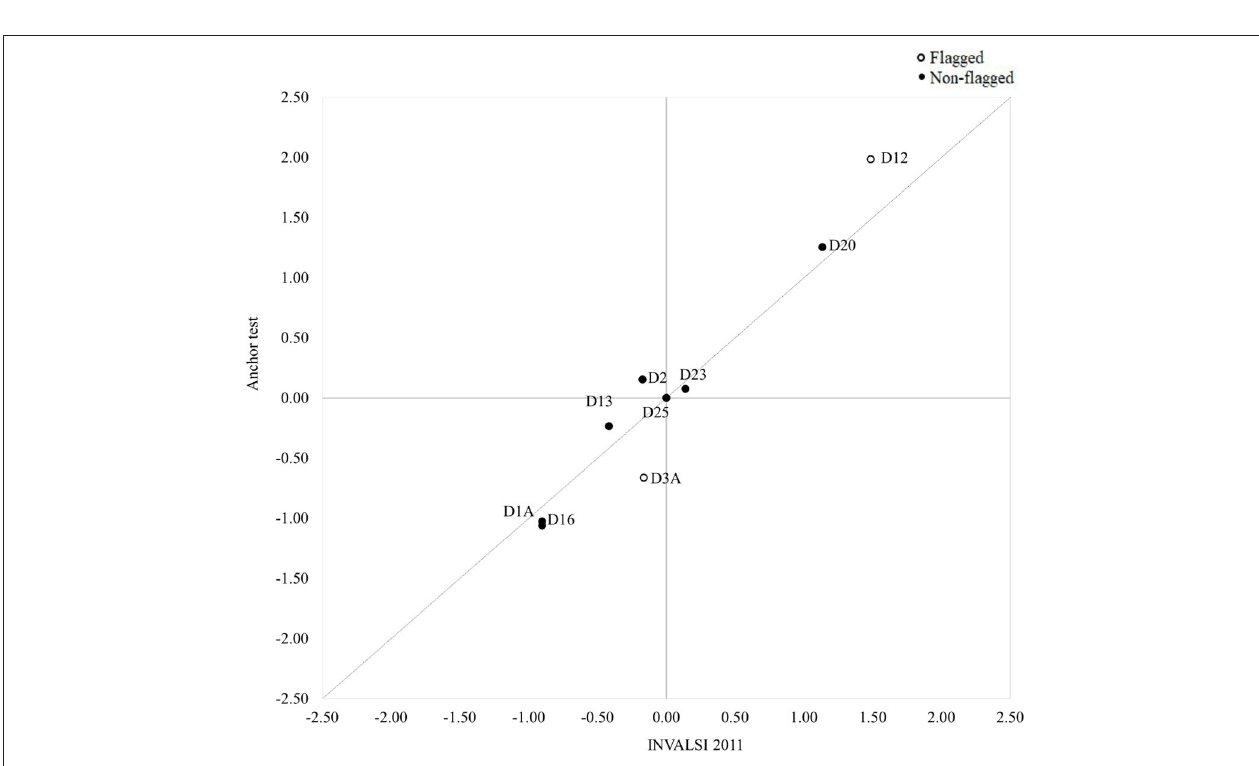
Frontiers in Applied Mathematics and Statistics |